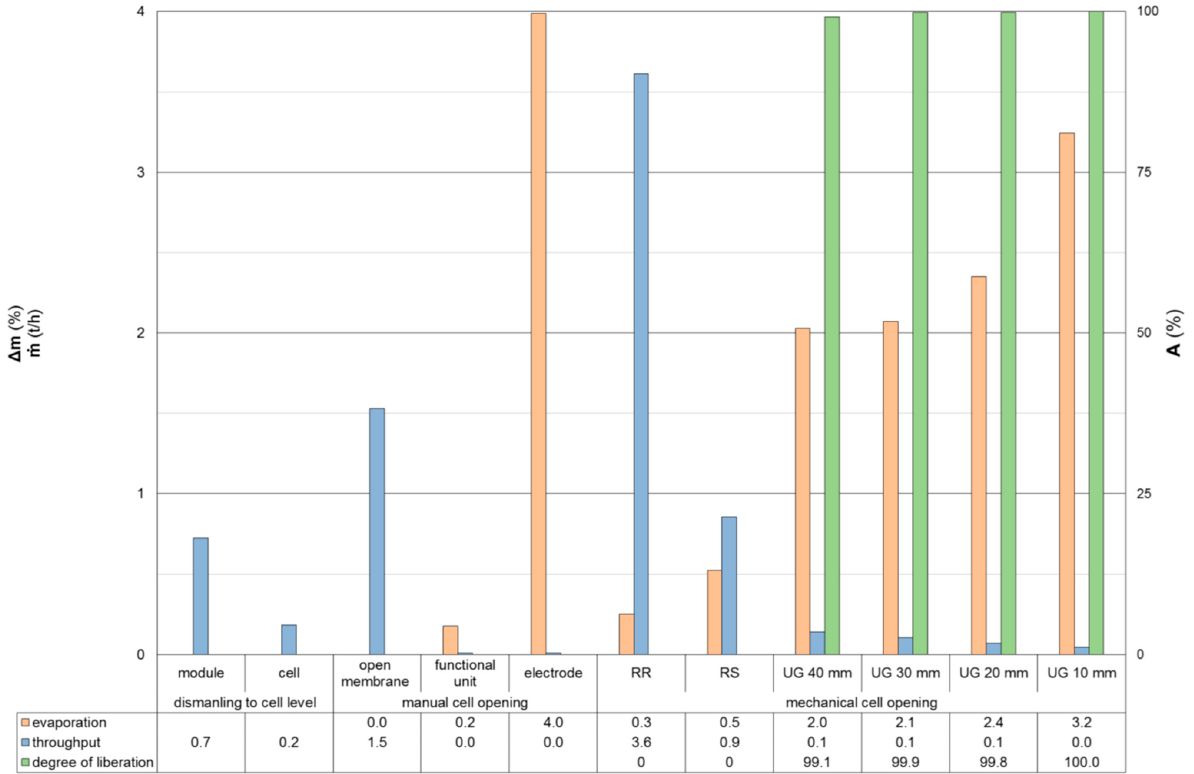
Figure 5. Influence of process step on relative mass difference by evaporation, throughput, and degree of liberation.